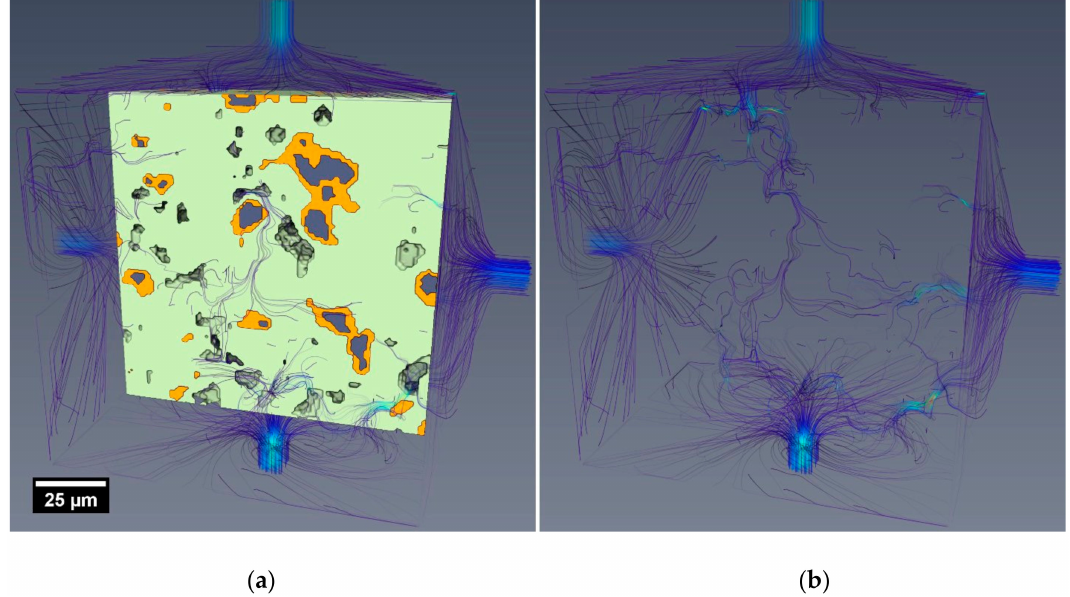
Figure 9. ( a ) Volume rendering of microstructure overlaid with simulated flow visualization. ( b ) Flow visualisations in X and Y directions (colour indicates velocity) for a 100 µ m cube (VOI) from the XR- µ CT scan of specimen C 10 7 days.